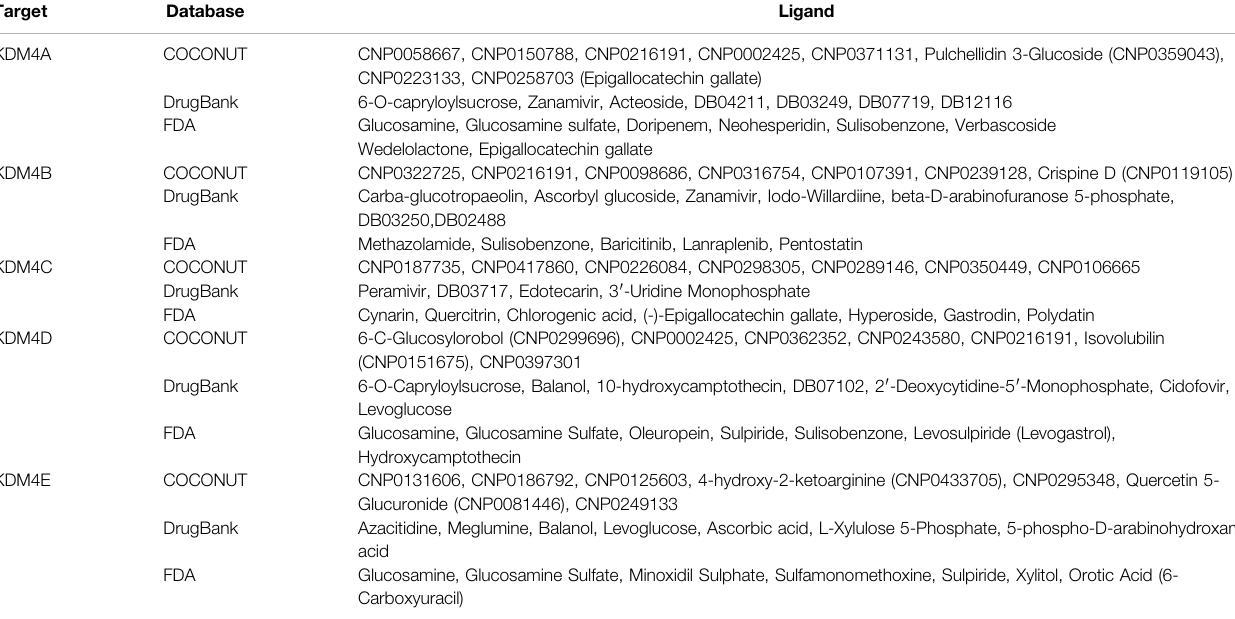
TABLE 2 | List of the top molecules with potential inhibitory activity of KDM4 subfamily proteins determined with molecular docking using COCONUT, DrugBank and FDA databases.